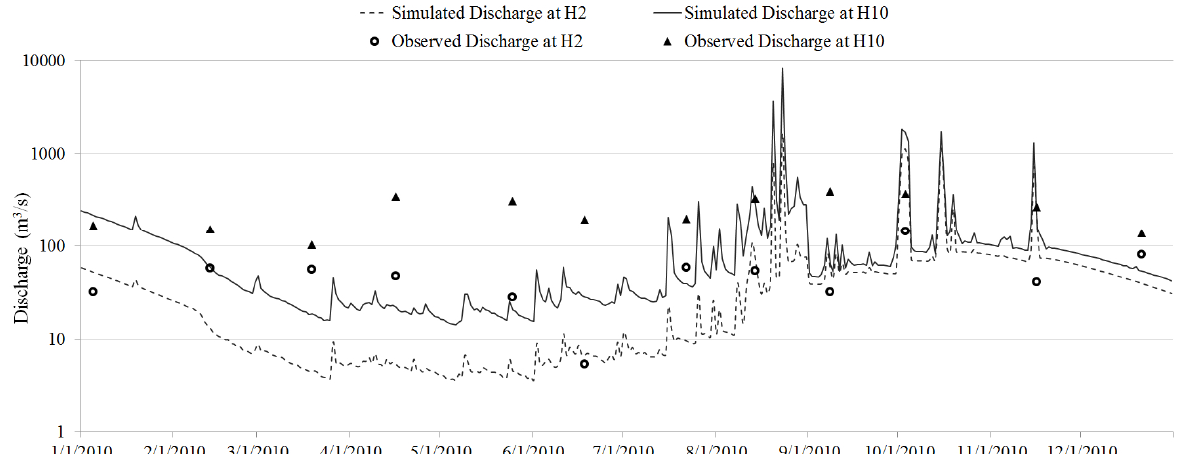
Figure 9. Simulated and observed discharge at H2 and H10 in